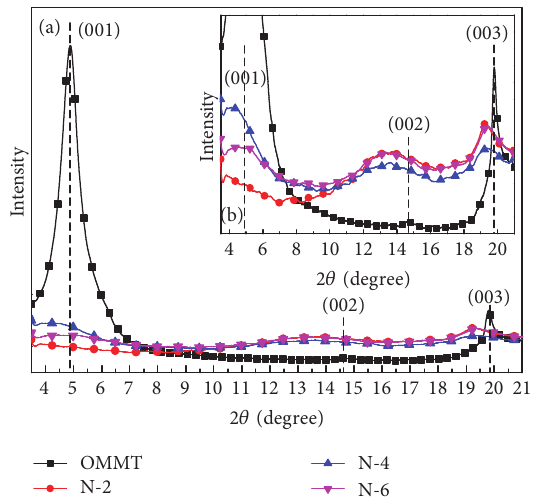
Figure1:WAXDpatternsofOMMTandnanocompositesN-2,N-4, and N-6: (a) original patterns; (b) magnified